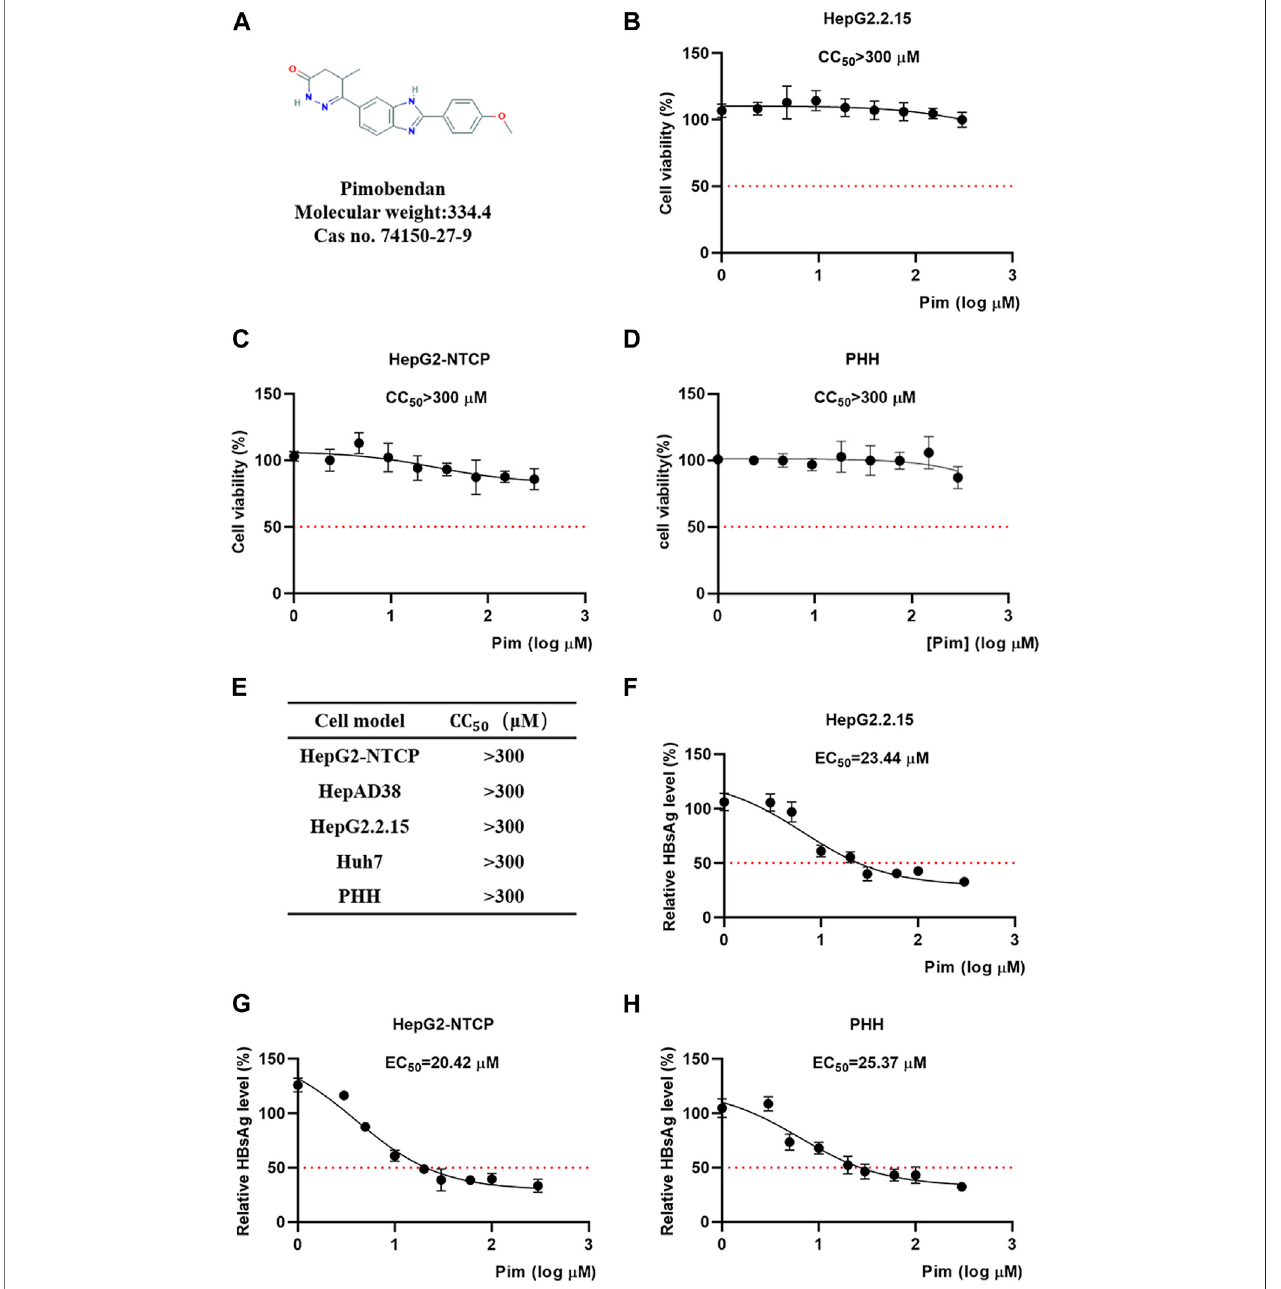
FIGURE 2 | Cytotoxicity and anti-HBV activity of Pim (A) The chemical structure of Pim (B – D) Effects of Pim on the cell viability of HepG2.2.15, HepG2-NTCP and PHH cells were determined by the MTT assay (E) Indicated cell lines were treated with various concentrations of Pim for 72 h and its 50% cytotoxic concentration was determined (F – H) The EC 50 of Pim on the inhibition of HBsAg in HepG2.2.15, HepG2-NTCP and PHH were determined by the ELISA assay. Pim treatment was started 72 h post HBV infection, and further treatment of Pim for 6 days in HepG2-NTCP and PHH cells.